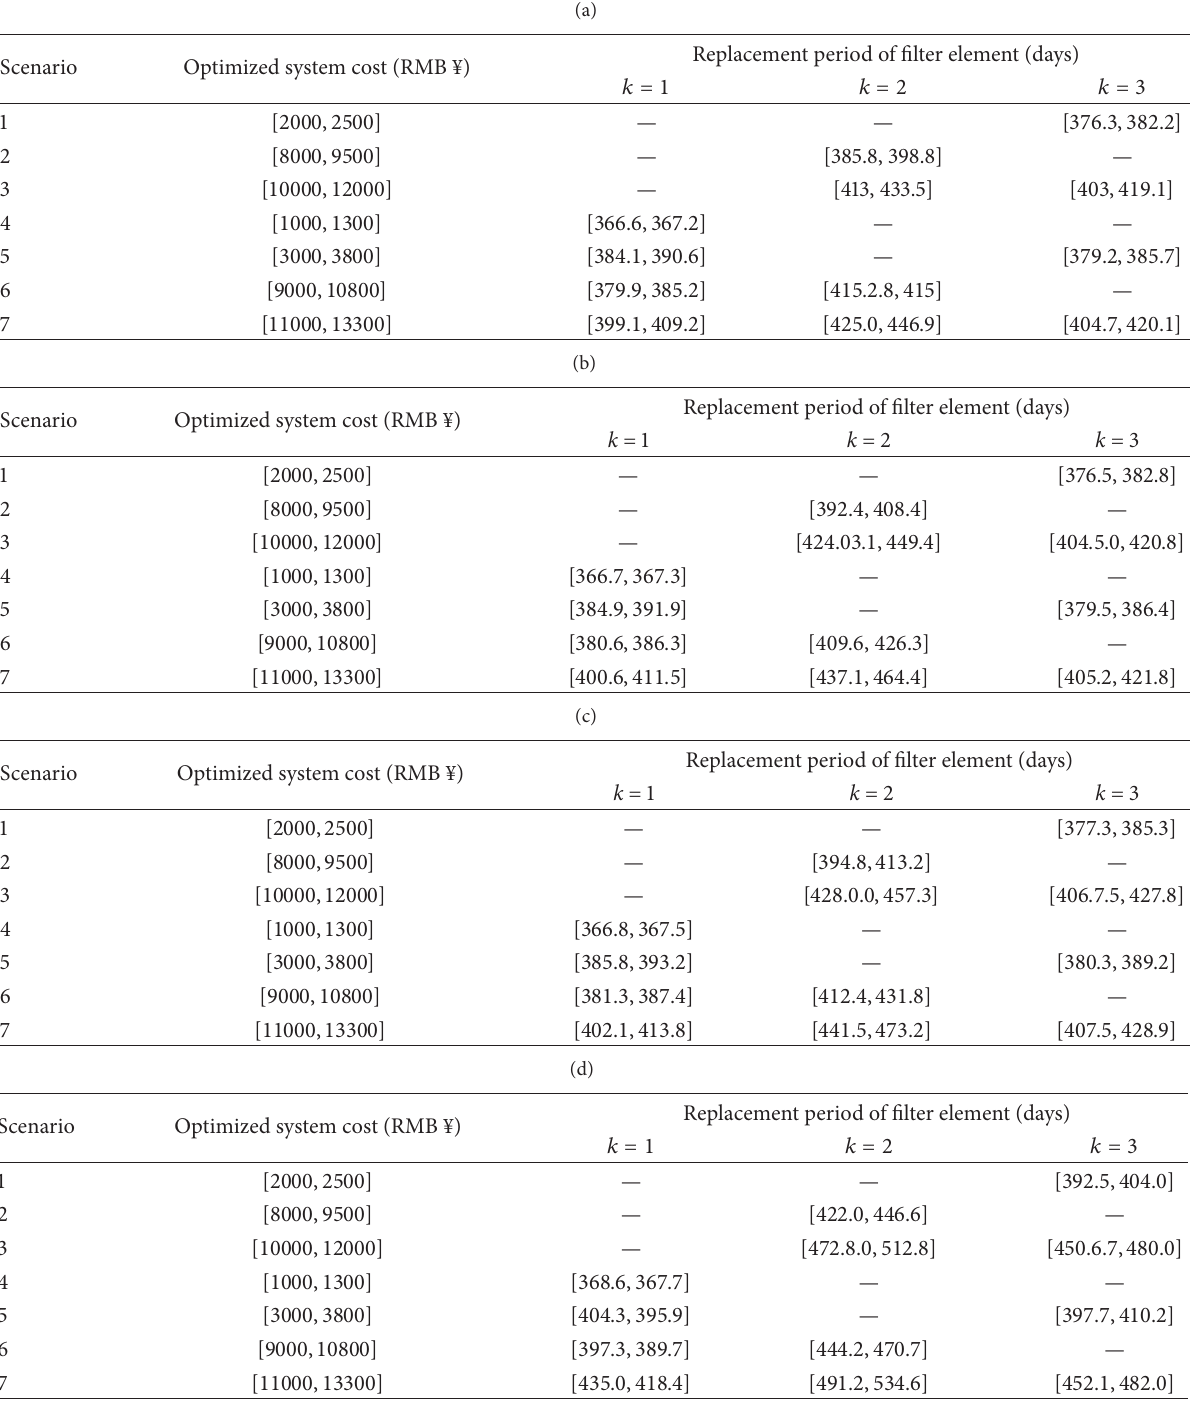
Table 6: (a) Results for optimized system cost and filter-replacement period under low ingression/generation rate (8 hours per day) (when = 0.10 ). (b) Results for optimized system cost and filter-replacement period under low ingression/generation rate (8 hours per day) (when 𝑝 1 = 0.15 ). (c) Results for optimized system cost and filter-replacement period under low ingression/generation rate (8 hours per day) (when 𝑝 2 = 0.20 ). (d) Results for optimized system cost and filter-replacement period under low ingression/generation rate (8 hours per day) (when 𝑝 3 = 0.30 𝑝 4